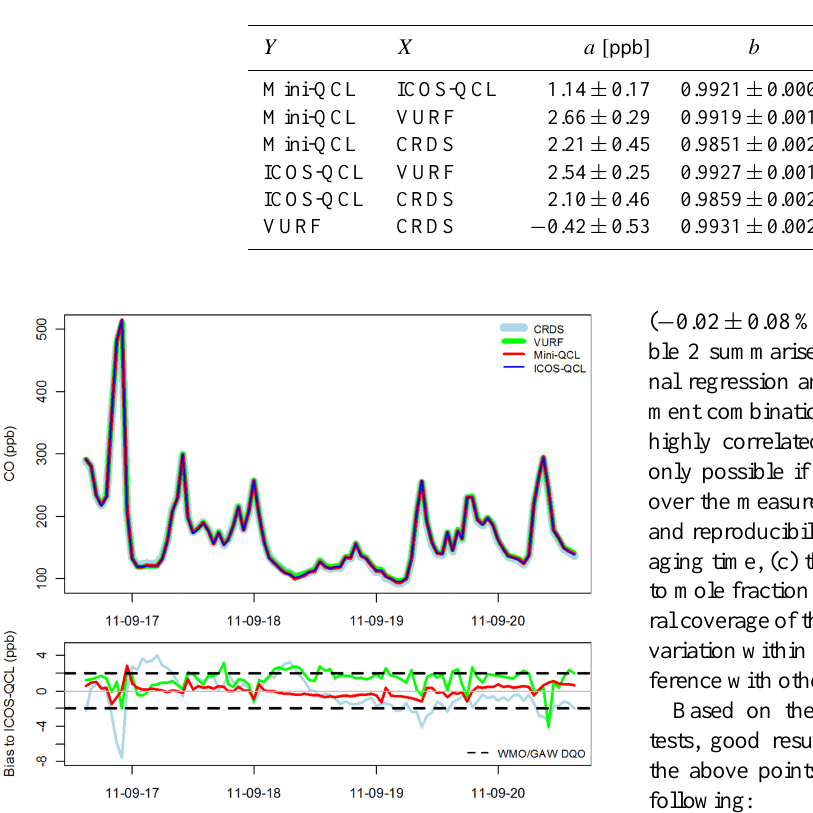
Table 2. Results of the orthogonal regression analysis between the different measurement techniques. X and Y are the corresponding instru- ments, a is the intercept, and b is the slope of the regression with standard uncertainties ( k =1). R 2 is the coefficient of determination and N is the number of data points (1-h values).